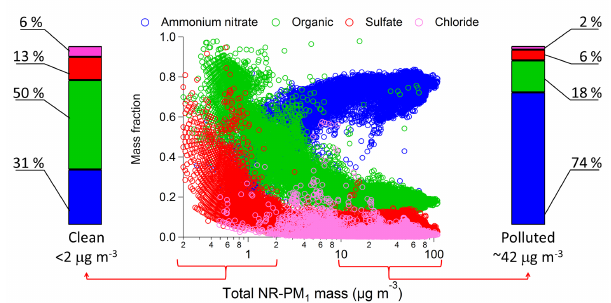
Figure 3. The center shows aerosol mass fraction as a function of the total mass of NR-PM 1 measured from the Twin Otter. Ammo- nium nitrate is in blue, organic species in green, and sulfate and chloride in red and pink, respectively. The bar chart on the left cor- responds to the average of the mass fractions when the total aerosol mass is <2µgm − 3 (clean conditions). The bar chart to the right corresponds to the average of the mass fractions when the total aerosol mass is >17.5µgm − 3 (polluted conditions) and altitude is <900ma.g.l. (below the boundary